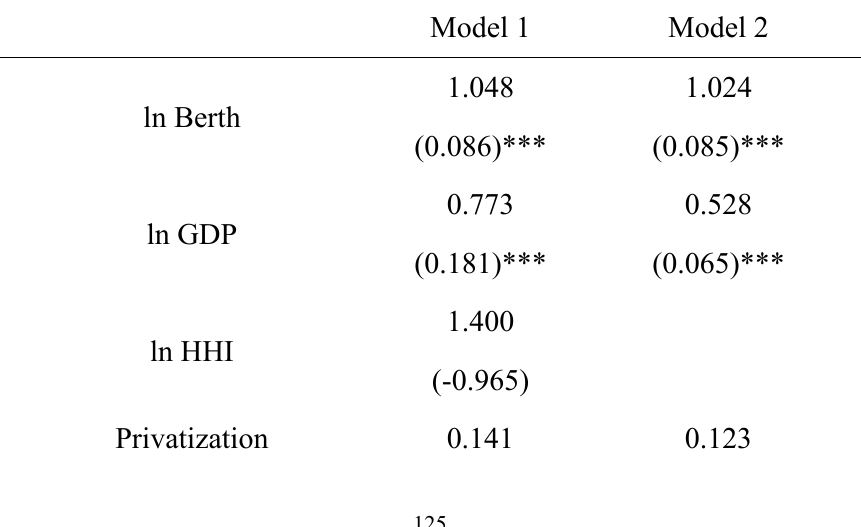
Table 4. Results of the Fixed Effect